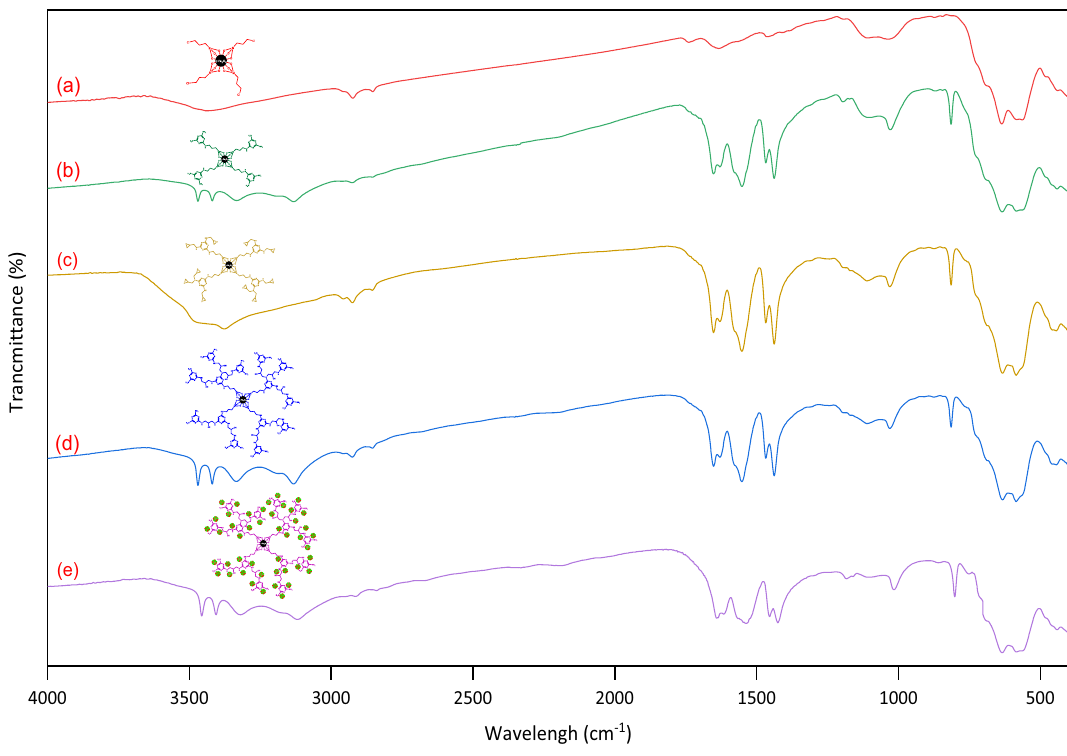
Figure 1. Plots of FT-IR spectra of ( a ) chlorofunctionalized γ-Fe 2 O 3 , ( b ) γ-Fe 2 O 3 -melamine, ( c ) γ-Fe 2 O 3 - melamine-ECH, ( d )